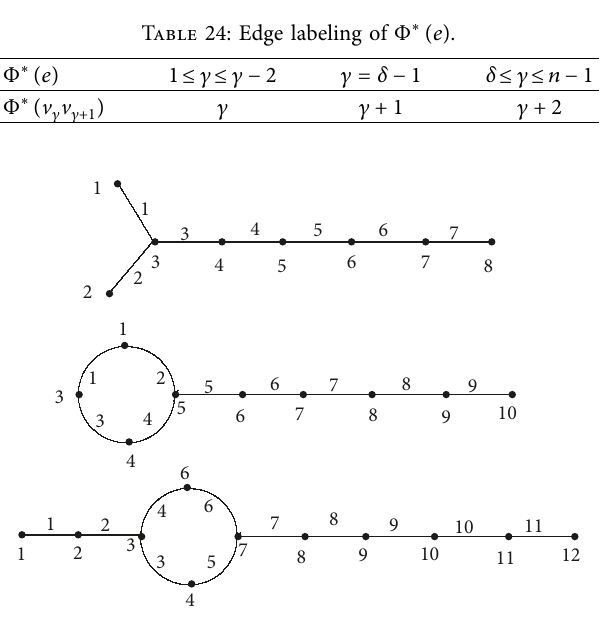
Figure 7: A classical mean labeling of G obtained by duplicating a vertex of a path.